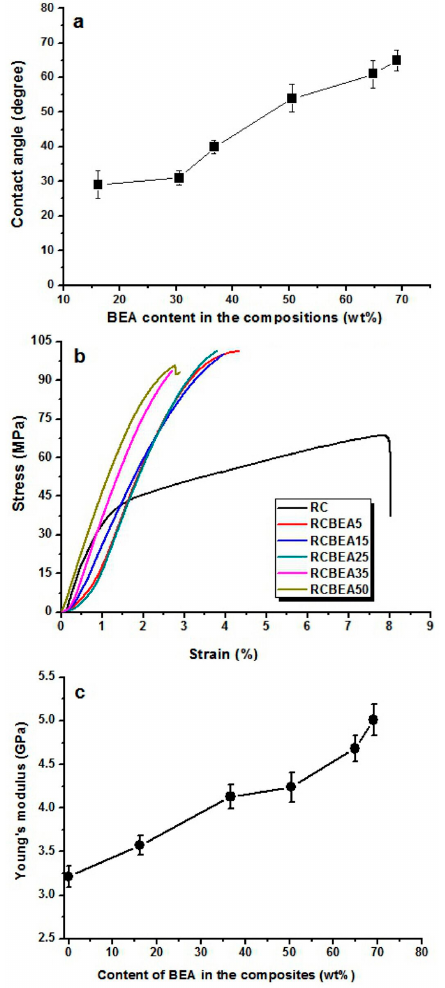
Figure 8. Contact angle images of water droplets on RC and composite films ( a ); and the stress-strain curves of the RC and composite films ( b ); and the corresponding Young’s modulus values of the films ( c ).